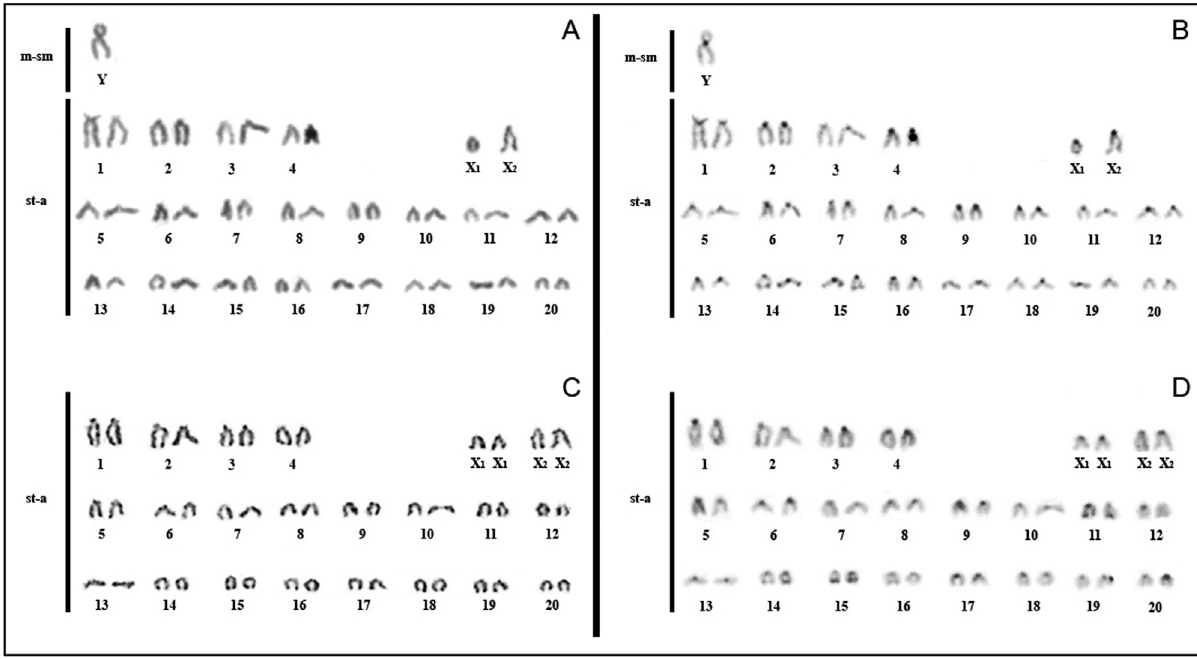
Figure2 -Karyotypesofmales(A,B)andfemales(C,D)of Brachyhypopomus